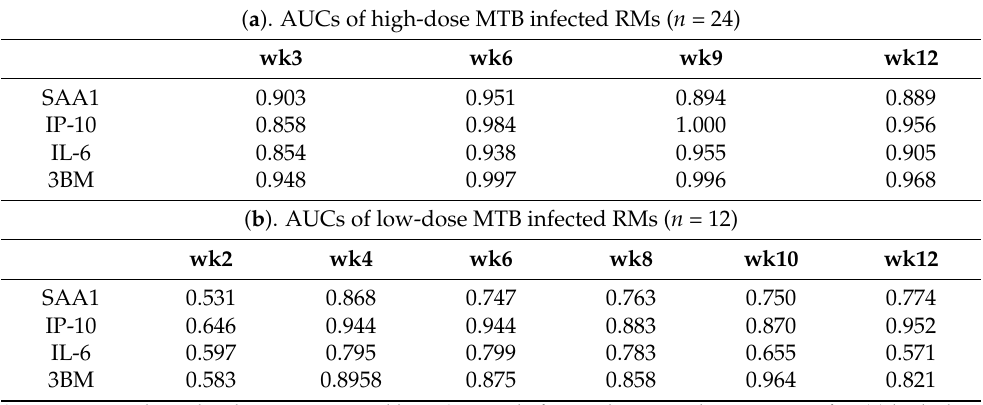
Table 2. Different assay performance of UCP-LFAs in high-dose and low-dose MTB infected rhesus